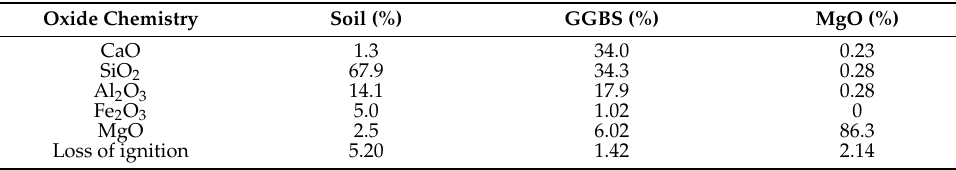
Table 3. Properties of the basalt fiber, GGBS, and